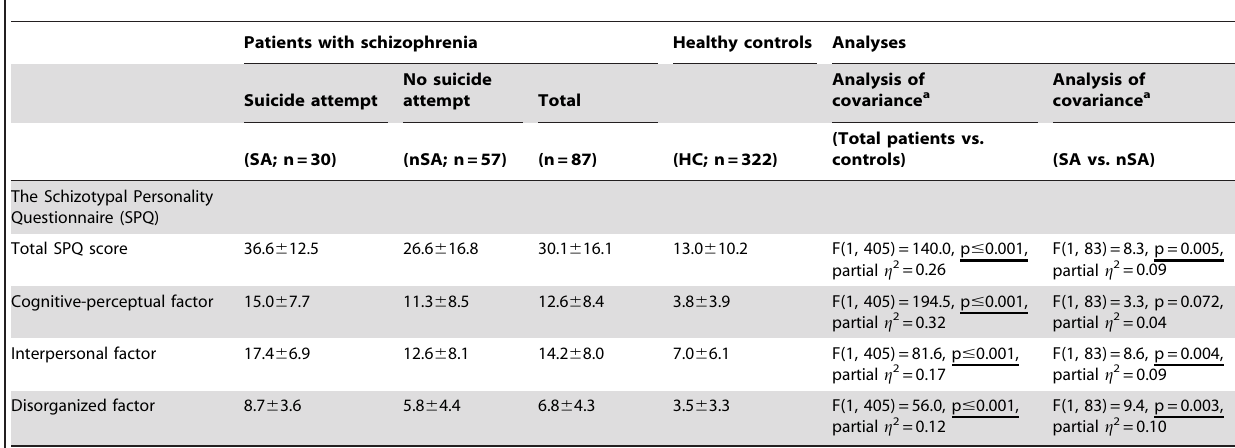
Table 2. Comparisons of the Schizotypal Personality Questionnaire (SPQ) scores between patients with schizophrenia with or without suicide attempts, and healthy